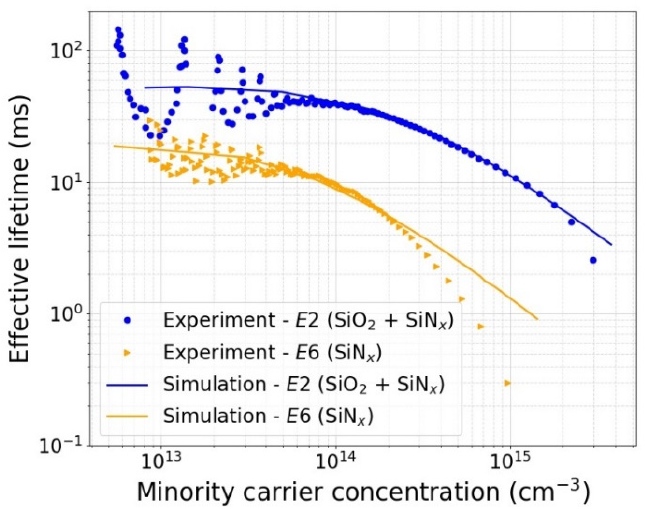
Figure 11. Injection dependent effective minority carrier lifetime τ eff ( Δ n) of test samples passivated with processes E2 (6 nm SiO 2 + 65 nm SiN x ) and E6 (65 nm SiN x ) as described in Table 1 with simulation fits to extract SRV and τ bulk .